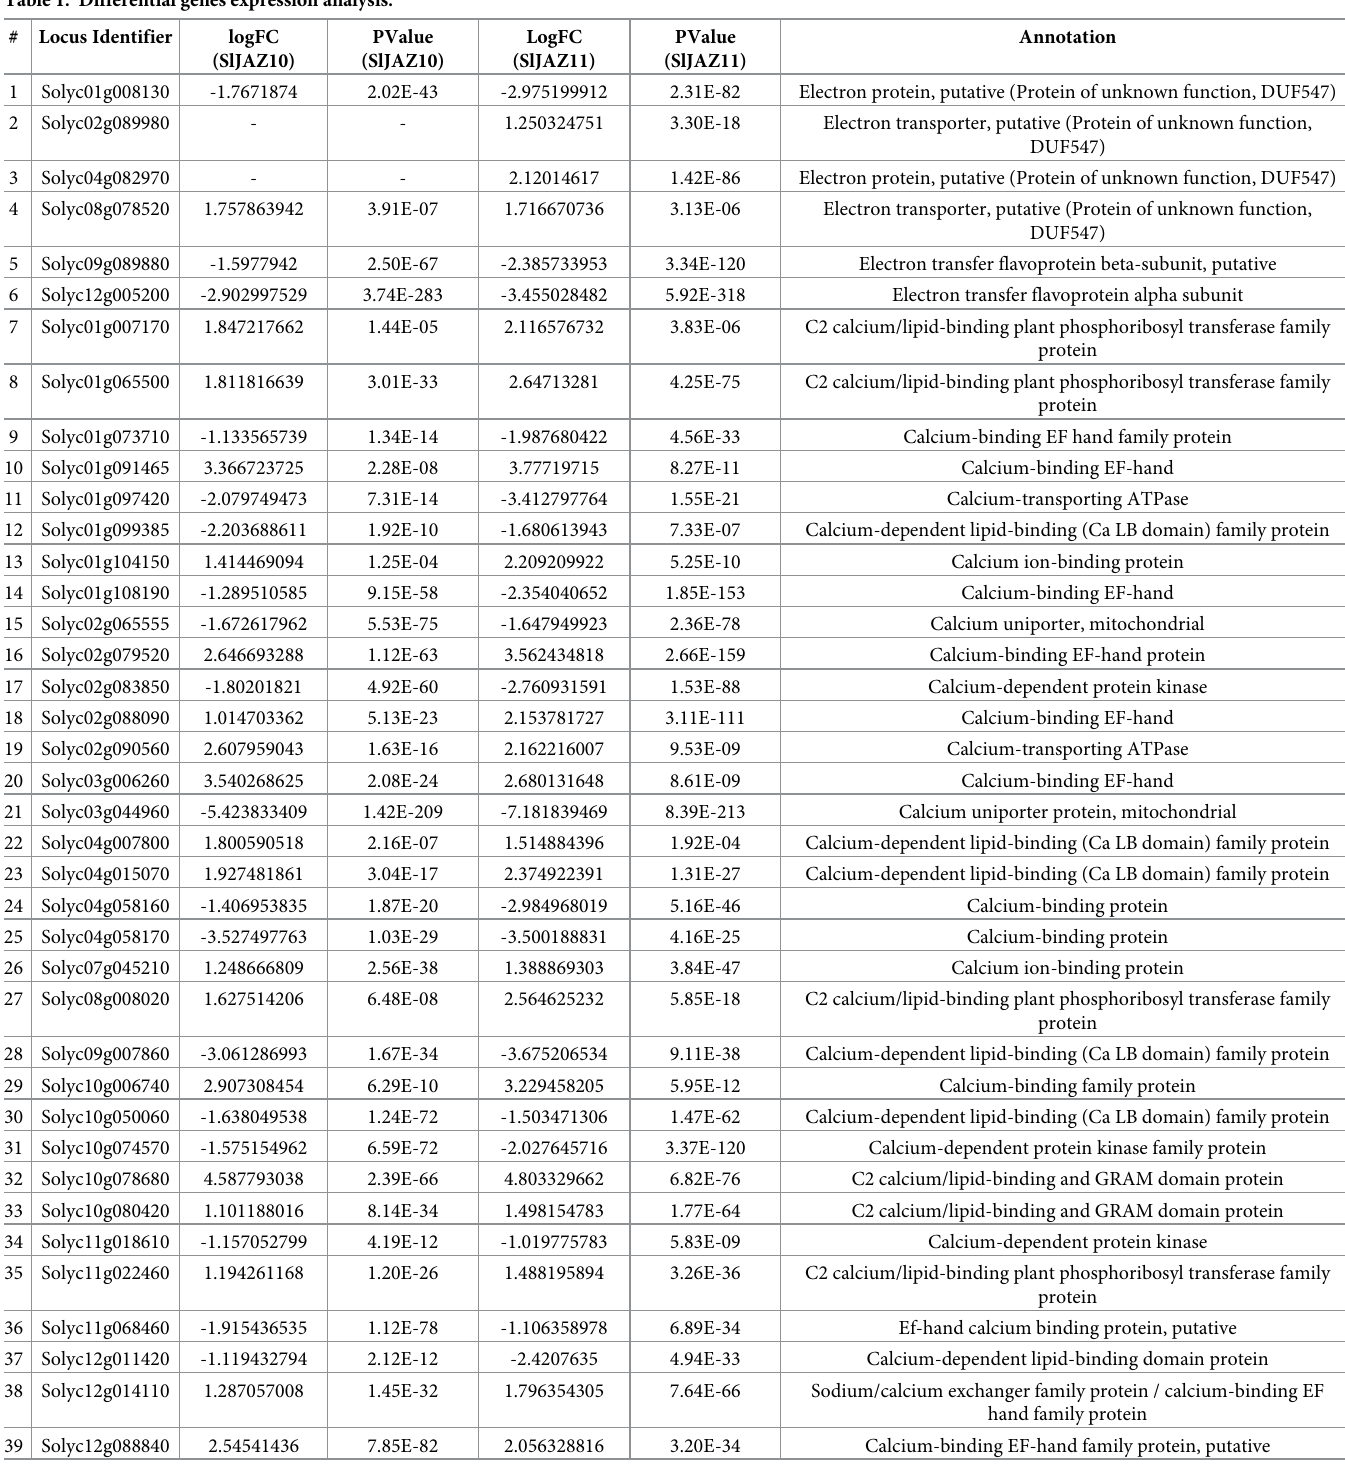
Table 1. Differential genes expression